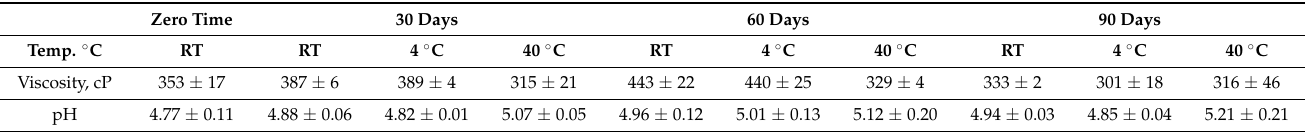
Table 3. Viscosity and pH of Weblike carrier at zero time, after 30, 60 and 90 days at RT, 4 ◦ C and 40 ◦ C, Mean ±